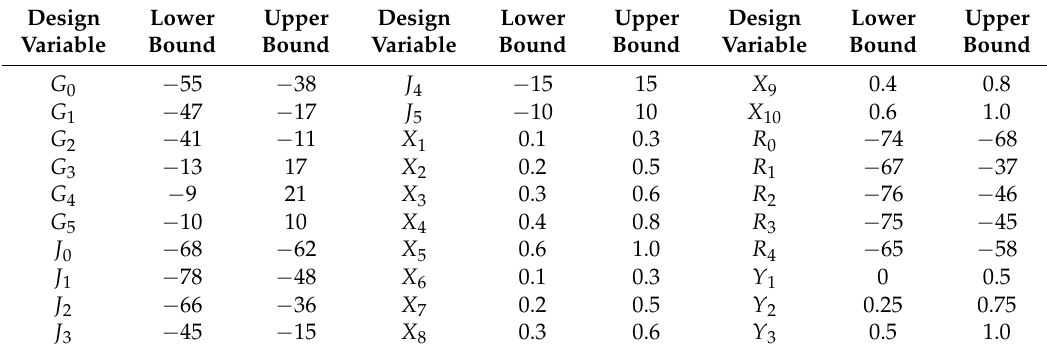
Table 1. Design variables.